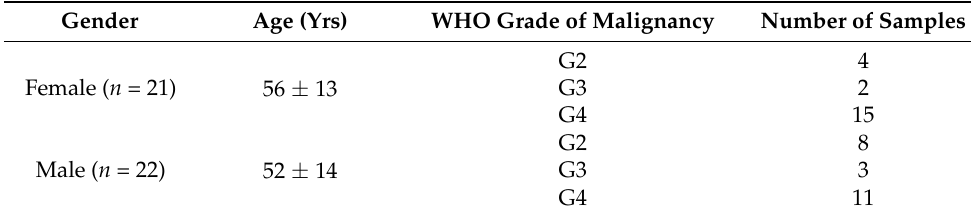
Table 1. Selected clinical features of the studied group of patients. Gender Age (Yrs) WHO Grade of Malignancy Number of Samples Female ( n =